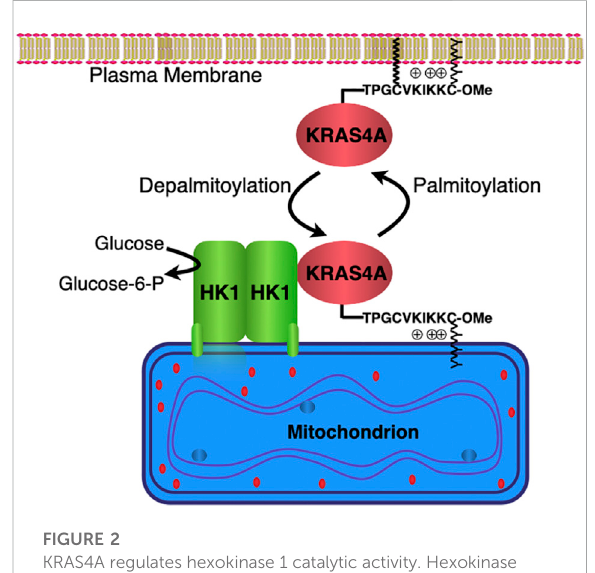
FIGURE 2 KRAS4A regulates hexokinase 1 catalytic activity. Hexokinase 1 (HK1) is resident on the outer mitochondrial membrane (OMM) owing to an N-terminal targeting sequence. KRAS4A undergoes a cycleofpalmitoylation/depalmitoylationoncysteine180that drives association with the plasma membrane or OMM, respectively. KRAS4A interacts with HK1 on the OMM in a GTP- dependent fashion and stimulates HK1 activity by limiting the allostericfeedbackinhibitionphysiologicallymediatedbyglucose-